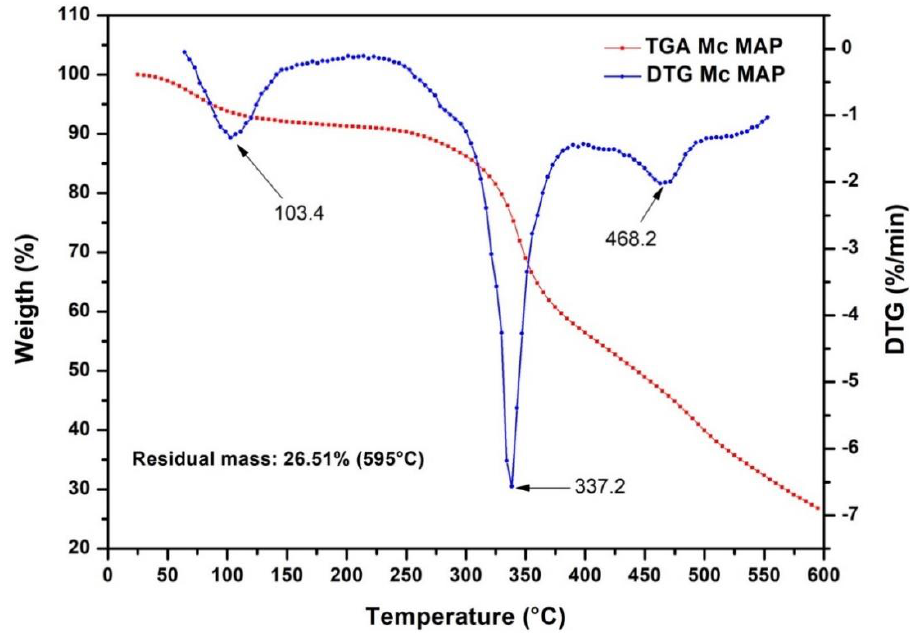
Figure 4. Thermogravimetric Analysis (TGA) and Differential Thermogravimetric Analysis (DTG) analysis of the McMAPs. Table 3. Result of decomposition temperature and residual mass of McMAPs microcapsules.